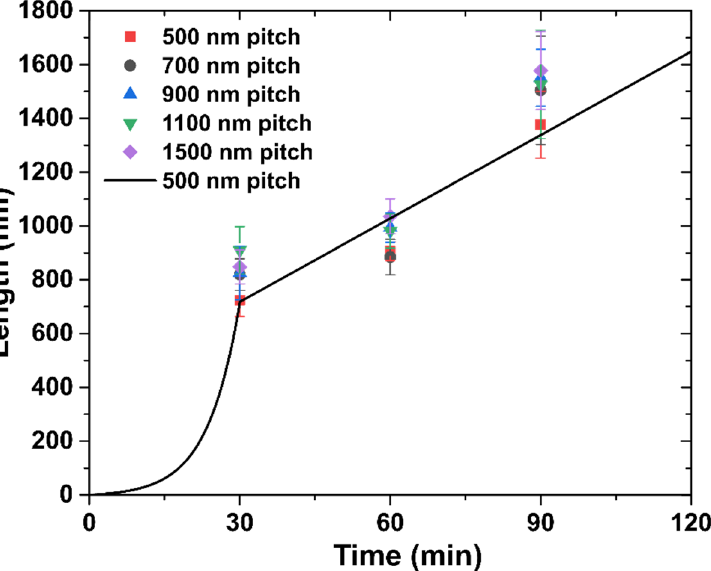
Figure 2. Dependence of the length of InSb NFs on the growth time for different pitches shown in the legend. Line shows the fit for 500 nm pitch.